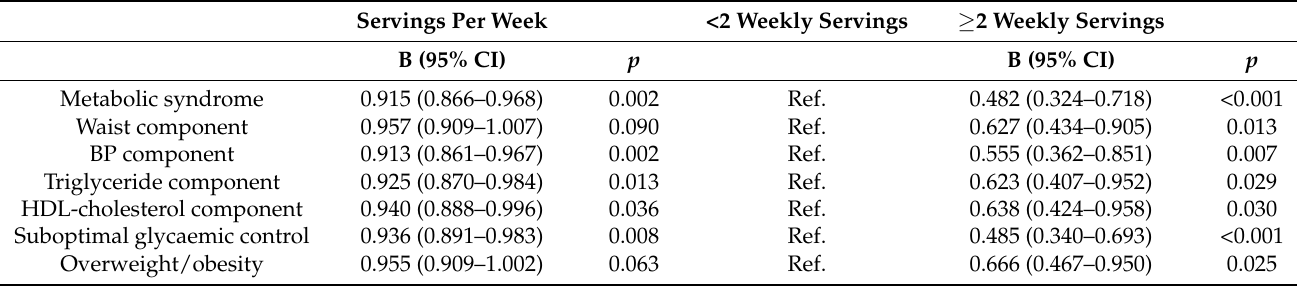
Table 3. Association between nut consumption and metabolic syndrome, its individual components, and